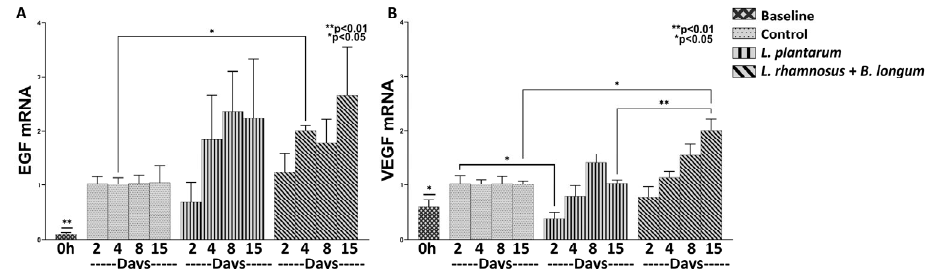
Figure 3. The effects of L. plantarum and the combination of L. rhamnosus and B. longum on angiogenesis. The mRNA expression of EGF ( A ) and VEGF ( B ) during the healing process. Results are presented as means with SEM. EGF Baseline: ** p < 0.01 compared to Control (Days 2–15), L. plantarum